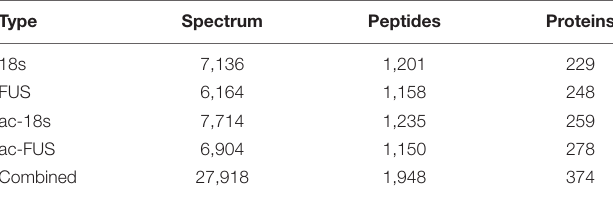
TABLE 2 | Differentially expressed proteins identified by mass spectrometry using HEK293T cells. Type ac-18s/18s ac-FUS/FUS Quant Num. 202 205 Sig. diff Num. 55 73 Sig. up num. 23 36 Sig. down num. 32